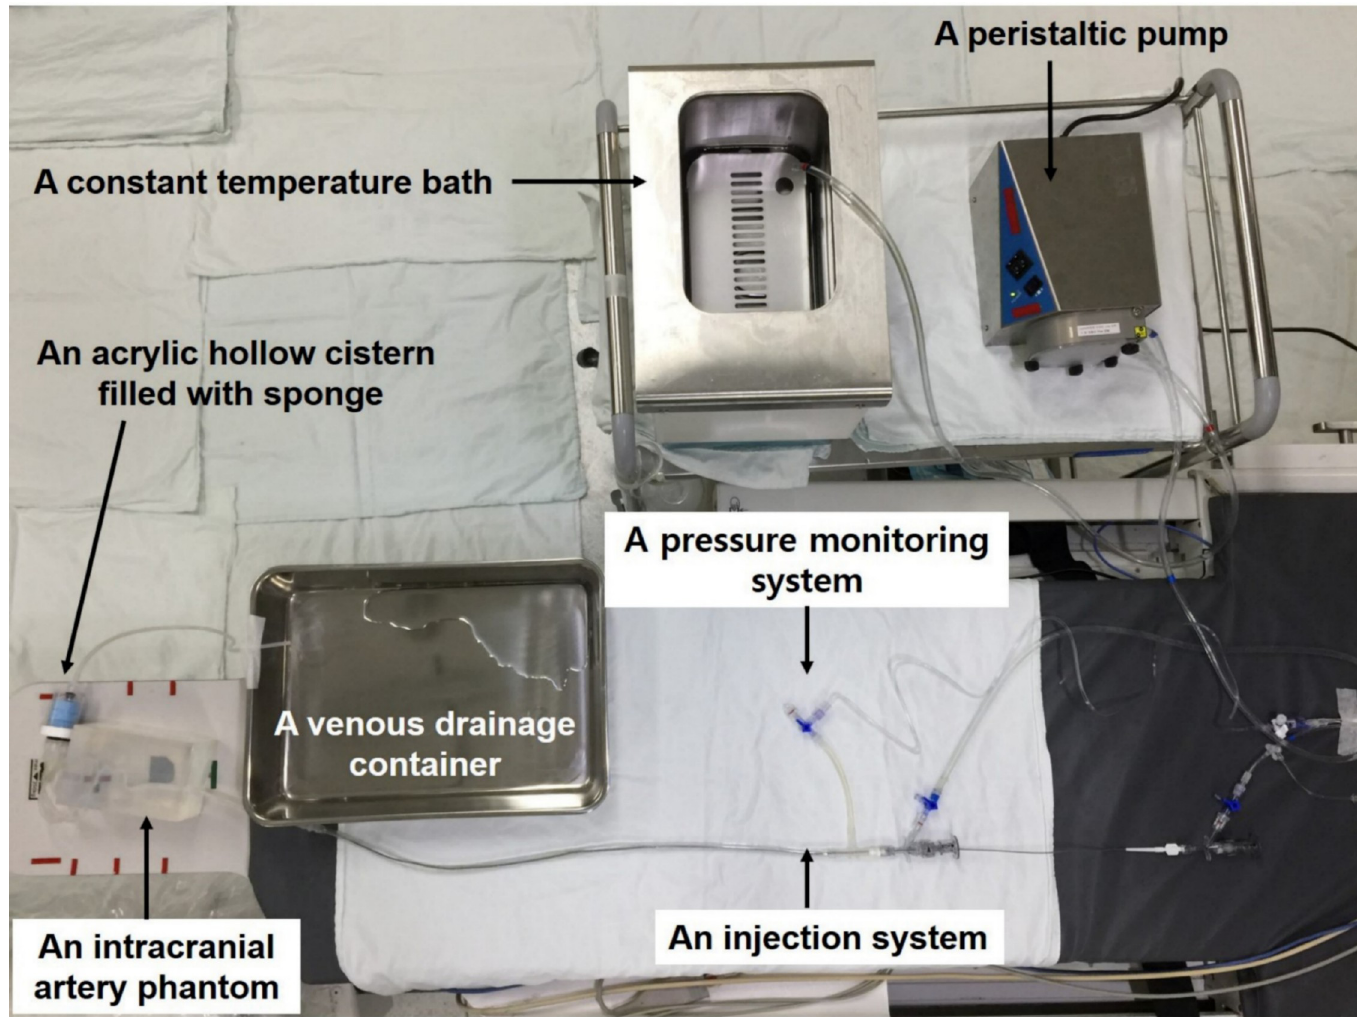
Fig 4. Photograph of the entire fluid circulation cerebral arterial silicone phantom